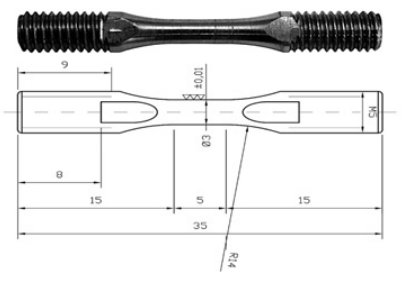
Fig. 1. Specimen geometry. Table 2. Experimental test planning.